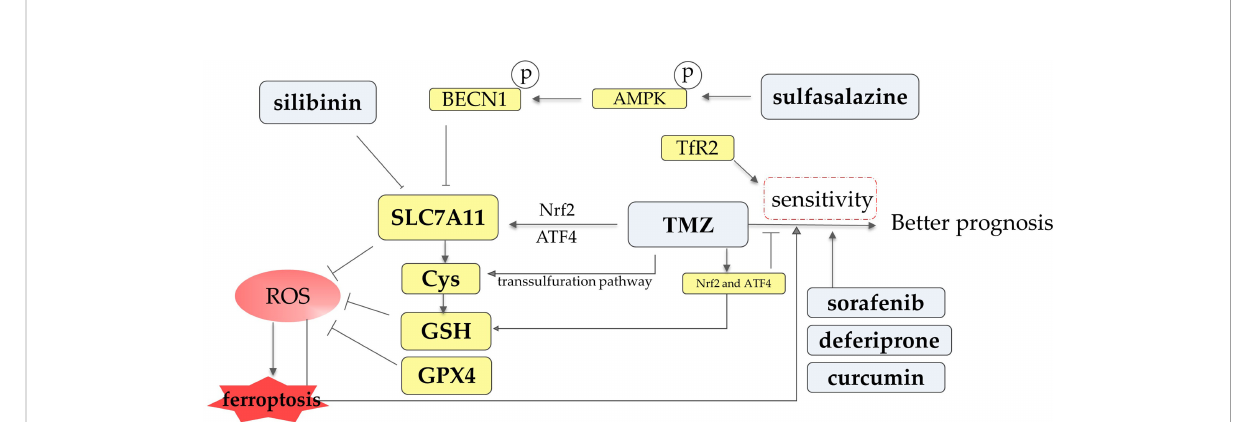
FIGURE 5 The association between drugs such as temozolomide (TMZ) and ferroptosis in glioma cells and some factors in fl uencing TMZ sensitivity. TMZ increases the levels of Nrf2 and ATF4 and thus induces the expression of SLC7A11 and GSH via multiple mechanisms. Silibinin and sulfasalazine inhibit the SLC7A11 subunit. TMZ facilitates Cys synthesis through the transsulfuration pathway. SLC7A11, GSH, and GPX4 suppress ROS formation, while ROS promotes ferroptosis. ROS overproduction is likely to be important in enhancing TMZ sensitivity. Sorafenib, deferiprone, and curcumin also increase the sensitivity of glioma cells to